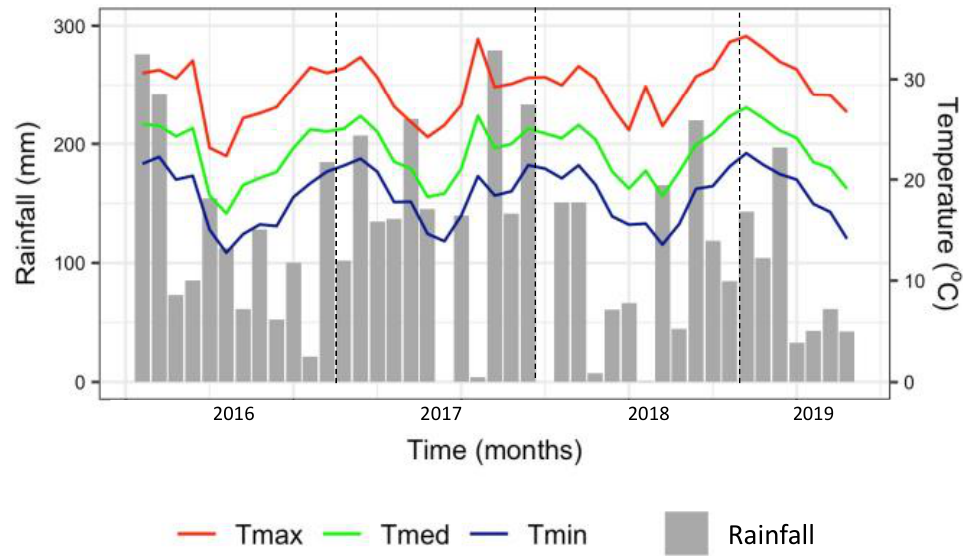
Figure 1. Monthly cumulative rainfall (mm) and maximum (Tmax), mean (Tmed), and minimum (Tmin) temperatures (°C) from January 2016 through July 2019 for Guairaçá, Paraná, Brazil. [21].